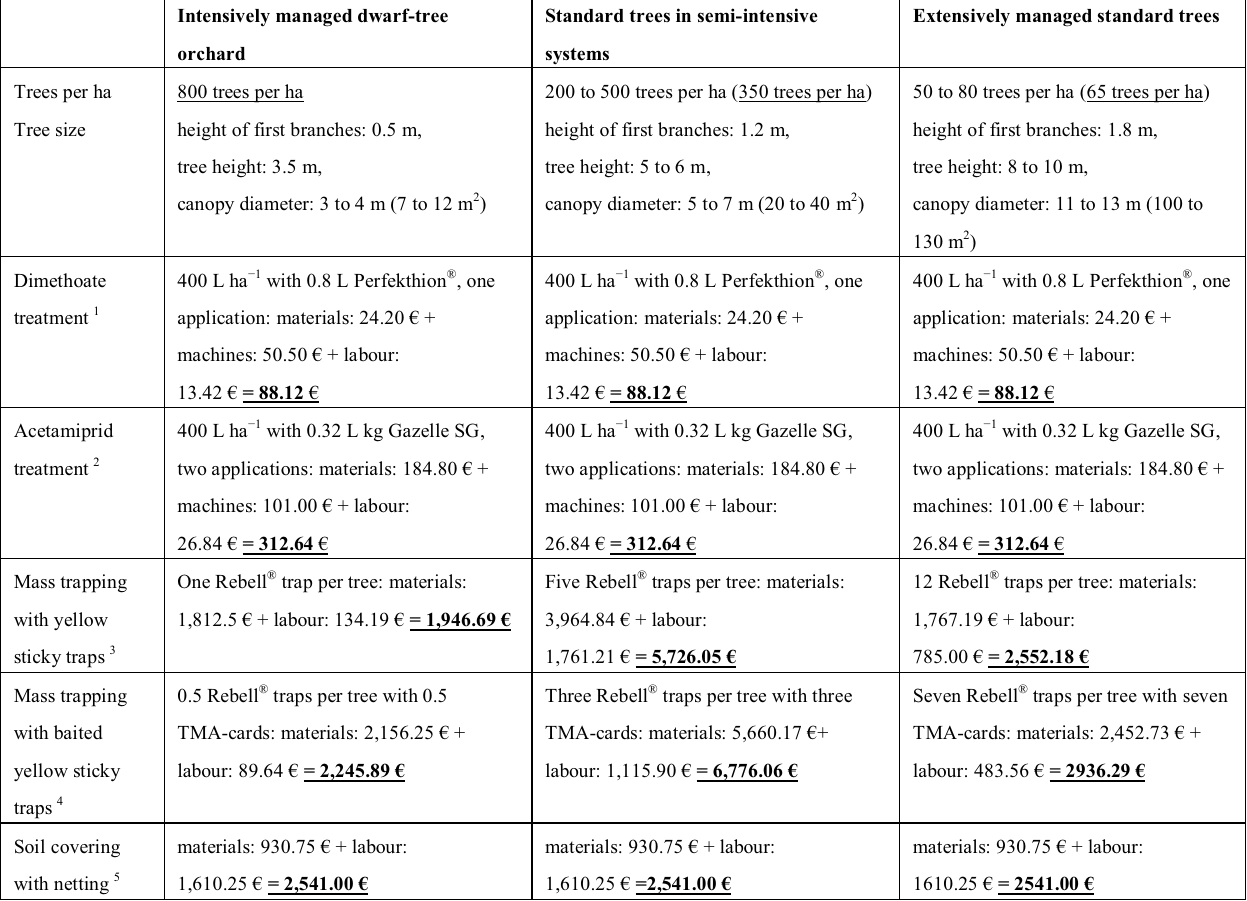
Table 2. Costs per hectare of different cherry fruit fly control